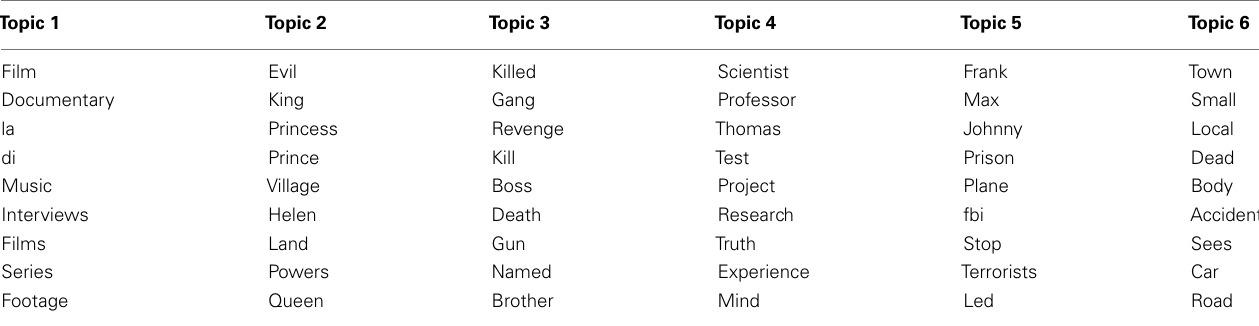
Table 8 | Selected